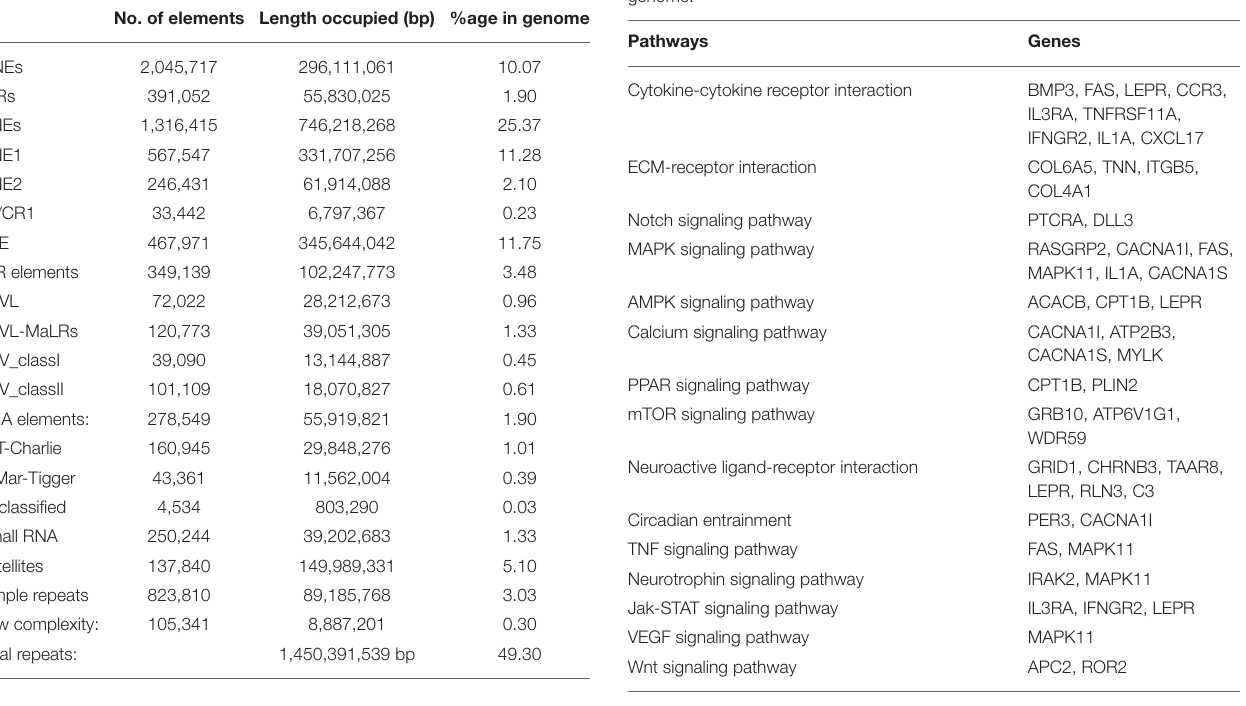
TABLE 1 | Repeat element statistics from Pashmina goat genome assembly. TABLE 2 | Pathways affected by high impact SNPs and InDELs in Pashmina goat